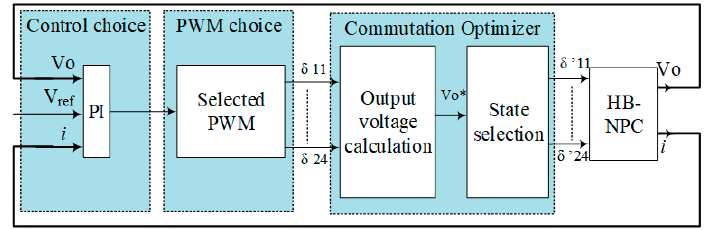
Figure 10. Scheme of the proposed OPT-PWM control strategy.